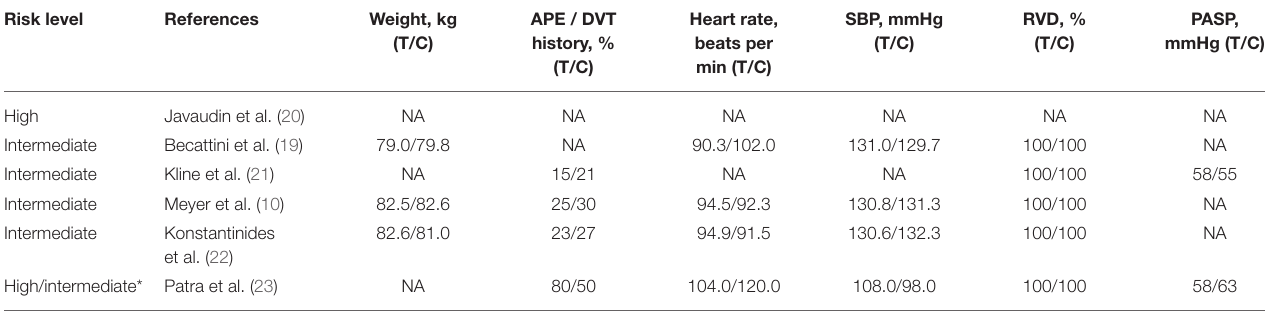
TABLE 2 | Baseline patient information of studies